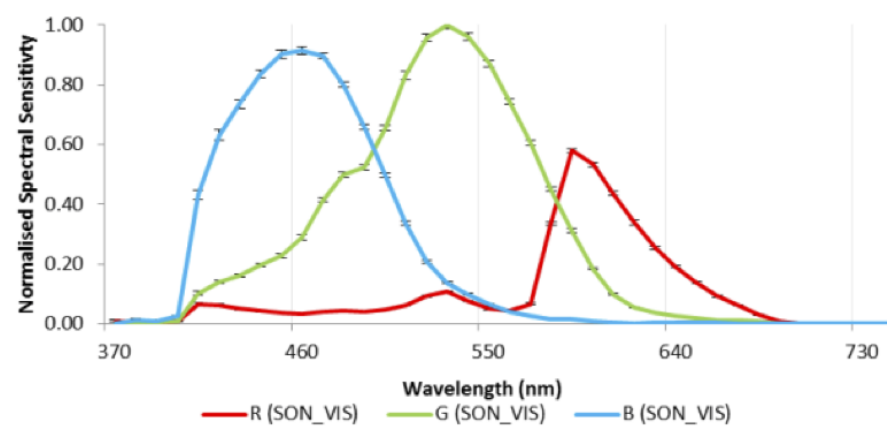
Figure 4. Spectral response for the unmodified Sony camera, normalised to the peak of the green channel (Source: Berra et al. [27]).